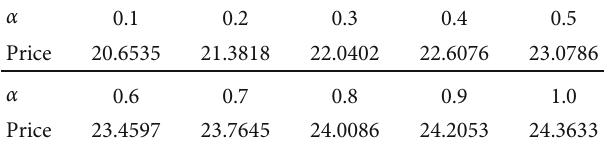
Table 2: Option prices with respect to α .